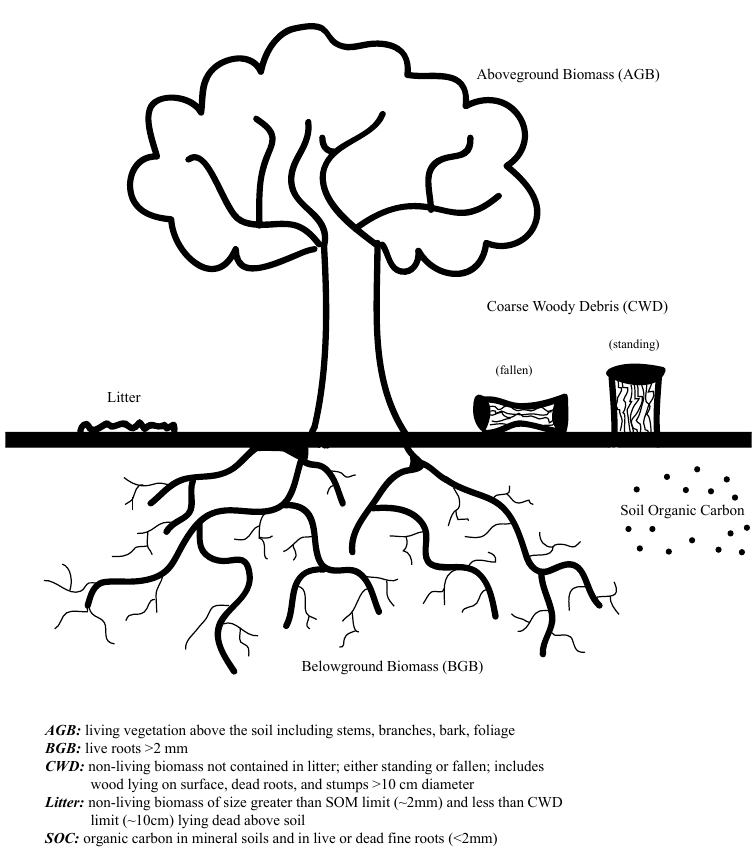
Figure 1. Carbon (C) continuously cycles between the atmosphere, the dead and living biomass, and soils of forest ecosystems [28]. For quantification and subsequent sampling purposes, it is recommended that forest C should be divided into five different pools: aboveground biomass, belowground biomass, soil, coarse woody debris, and litter